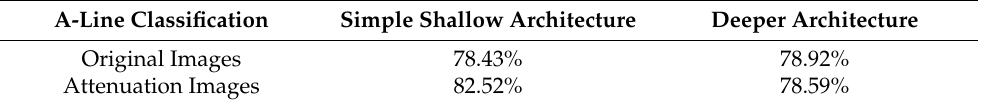
Table 3. The best test accuracy of A-lines (1 × 90) for original images and attenuation